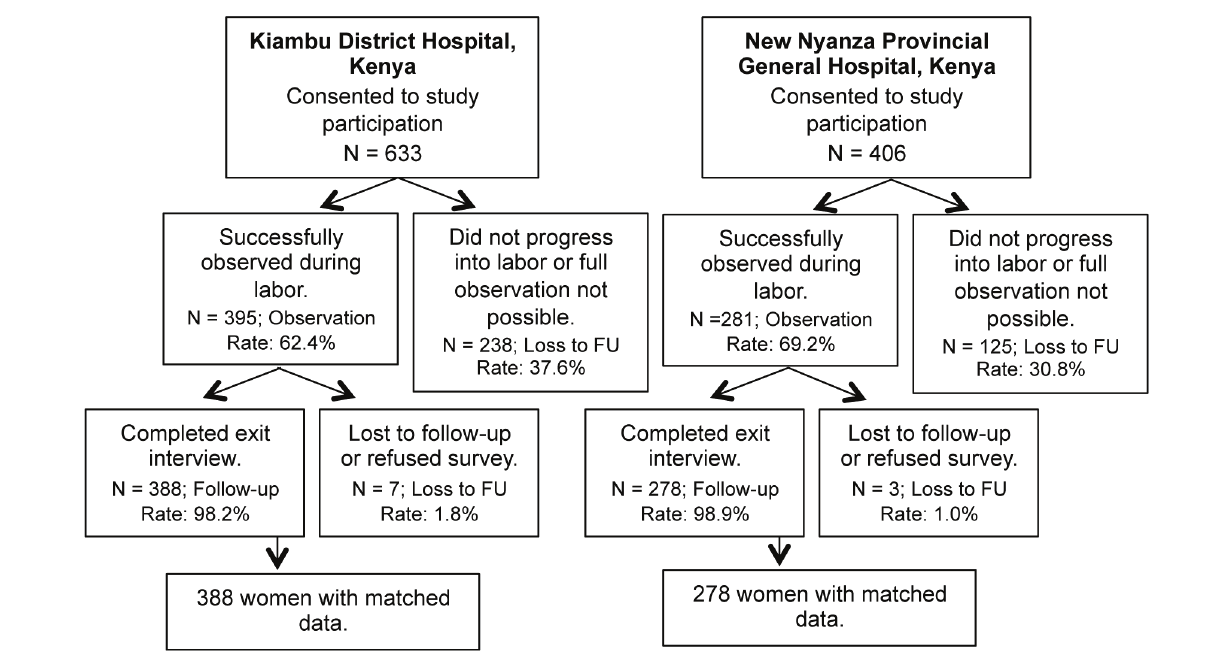
Figure 1. Participant response rates.